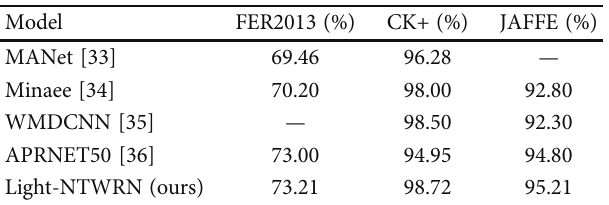
Table 7: Recognition rates of various algorithms on the facial expression